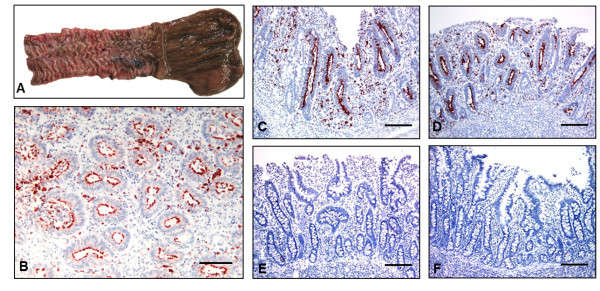
Pathological findings. A) Terminal ileum. Equine isolate-infected foal euthanized on day 24 pi. Hyperaemia associated with diffuse and severe thickening of the intestinal mucosa compatible with PE. B) Histologic section of ileum. Equine isolate-infected foal euthanized 24 days pi. L. intracellularis antigen-specific staining with AEC substrate-chromogen and counterstained with Mayer’s hematoxylin. Diffuse hyperplasia of immature enterocytes and severe reduction in the number of goblet cells associated with the diffuse presence of intracellular bacteria in the apical cytoplasm. Scale bar, 100 μm. C–D) IHC staining. Ileal mucosa of porcine isolate-infected pigs euthanized 21 days pi. Diffuse presence of the bacteria in the apical cytoplasm of the hyperplastic enterocytes and in the lamina propria. Scale bar, 200 μm. E–F) IHC staining. Ileal mucosa of equine isolate-infected pigs euthanized 21 days pi. Absence of hyperplastic enterocytes or L. intracellularis antigen associated with diffuse presence of goblet cells in the intestinal epithelium. Scale bar, 200 μm.